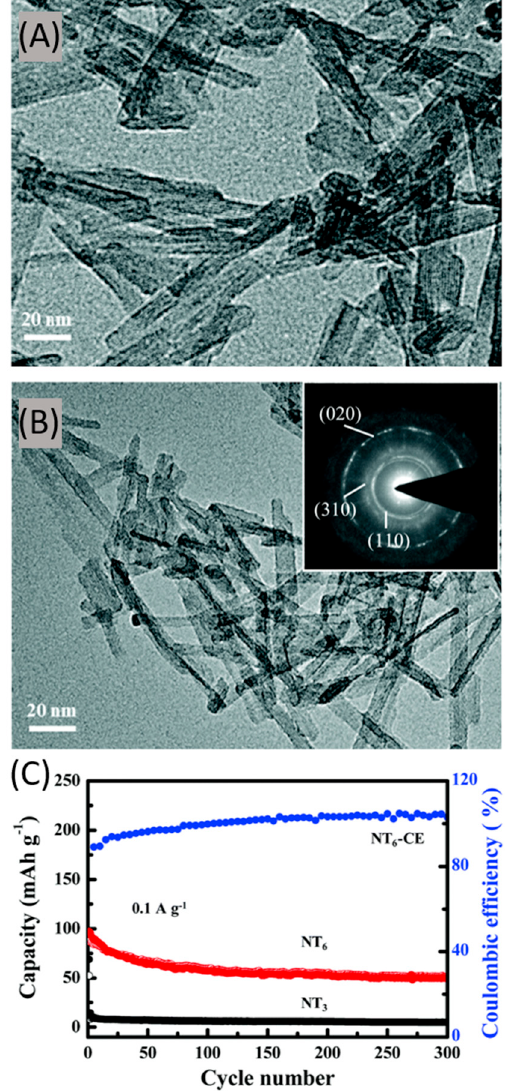
Figure 12. Transmission electron microscopy (TEM) images of ( A ) Na 2 Ti 3 O 7 NWs and ( B ) Na 2 Ti 6 O 13 NWs; ( C ) Cycling performance of Na 2 Ti 3 O 7 and Na 2 Ti 6 O 13 NWs at 0.1 A g − 1 . Adapted with permission from [177]. Copyright American Chemical Society, 2020.